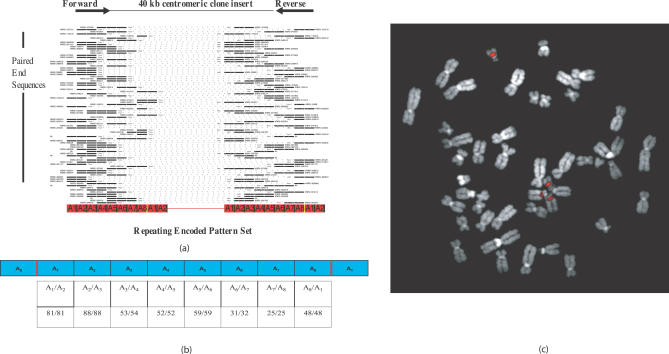
Novel HORs in Human(A) Paired-end sequence confirmation. Mate-pairs corresponding to a previously undescribed human pattern set (predicted 8-mer higher-order array) are shown. Black lines represent the left and right end sequences of each insert mapping to the same repeating encoded pattern set (red bars); dashed lines correspond to the unsequenced portion of the insert (40 kb in this case). The majority of end-sequence pairs map to the same repeat, confirming long-range tandem repeat organization.(B) Adjacency statistics for the new human higher-order array. The adjacency statistics simply calculates the number of times a specified monomer within the WGS sequence read maps adjacently to another specified monomer within the predicted HOR unit. The table shows data for a new human HOR sequence in Chromosomes 14 and 22.(C) FISH mapping (fosmid probe 3219L12) of predicted human higher-order array against metaphase spread of human chromosomes shows signals specific to Chromosomes 14 and 22 centromeres. Multiple clones from this encoded pattern set (3343N10, 3361F03, 3355D04, and 3355D08) showed identical results.